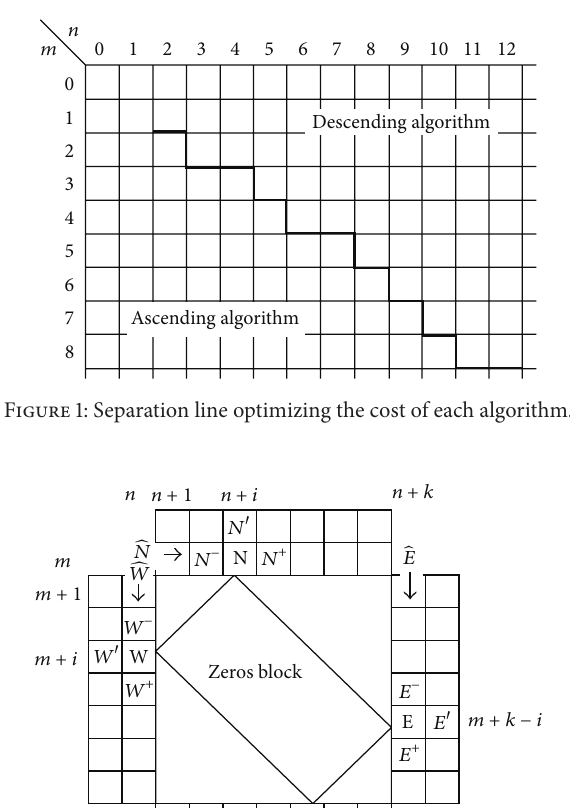
Figure 4: East and south shadow regions in the 𝑐